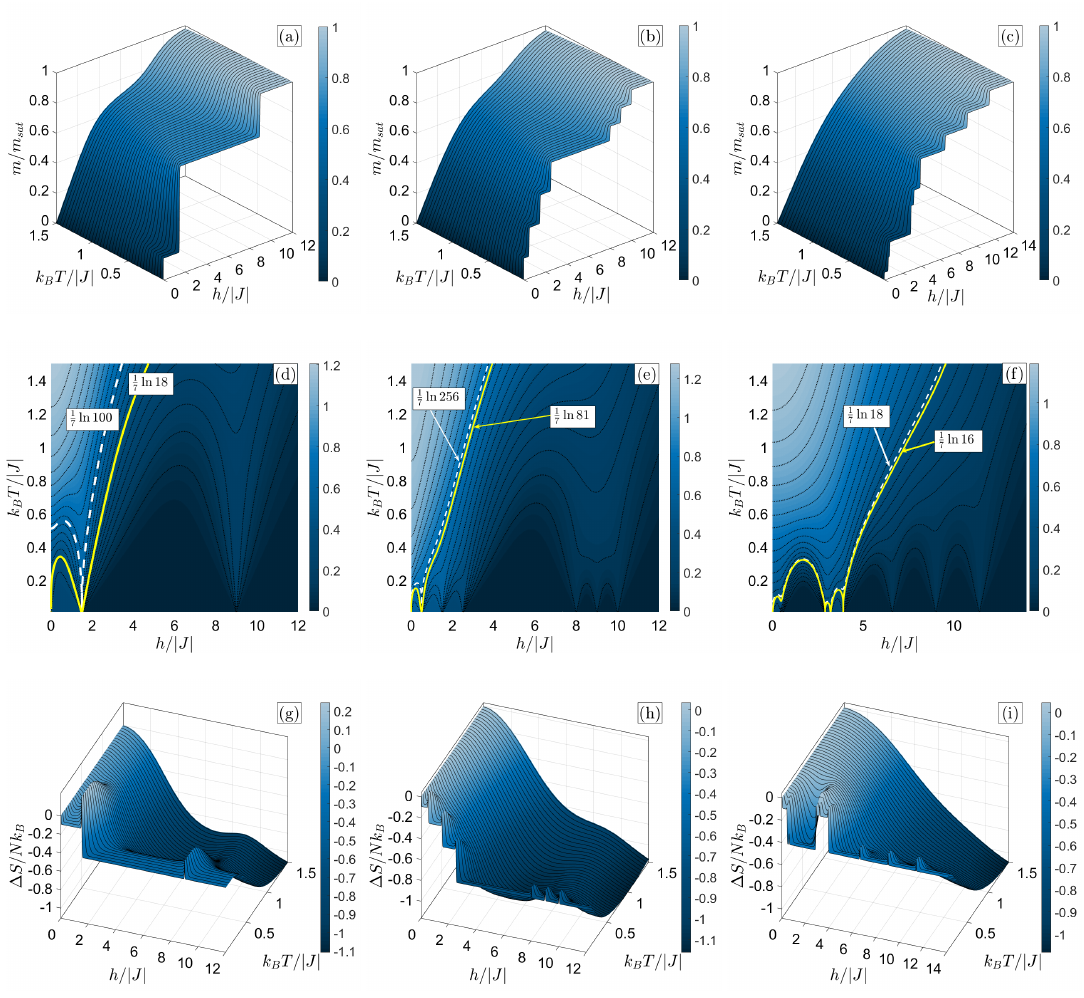
Figure 8. Magnetization ( a – c ), entropy density ( d – f ), and isothermal entropy density change ( g – i ) in k B T / | J | − h / | J | plane, for 2CS cluster with s = 3/2 and D / | J | = 0 ( a , d , g ), D / | J | = − 0.5 ( b , e , h ), and D / | J | = − 1.2 ( c , f , i ). The highlighted isentropes in the middle row correspond to the GS residual entropies at the first two critical fields h c 1 / | J | (solid yellow) and h c 2 / | J | (dashed